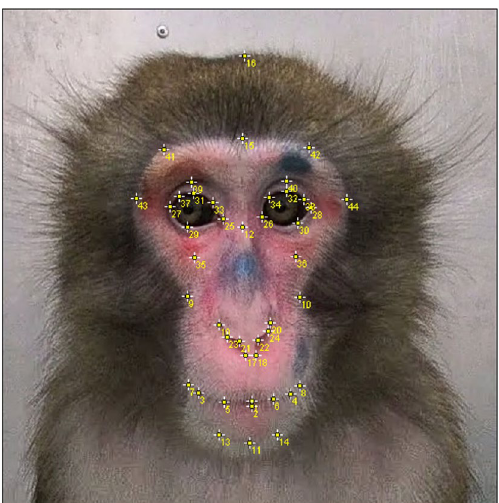
Figure 1. Anatomical landmarks and descriptions. Landmarks (n = 44) were manually annotated in facial images of Japanese macaques for shape analysis. For more information about the landmarks and their placement, see Supplementary Data